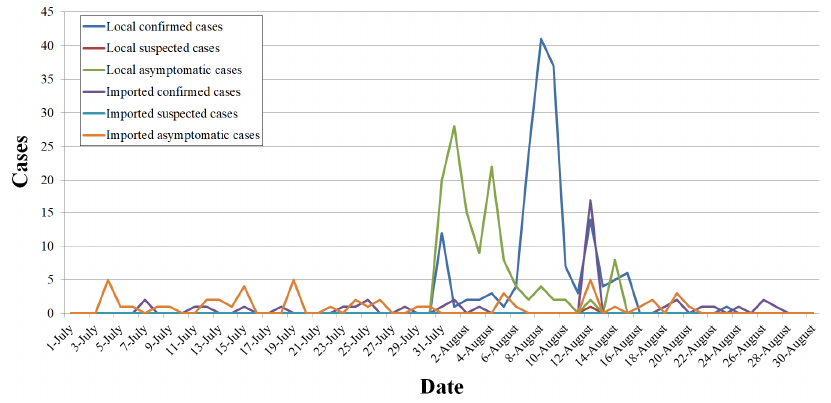
Figure 6. Local and imported cases of COVID-19.